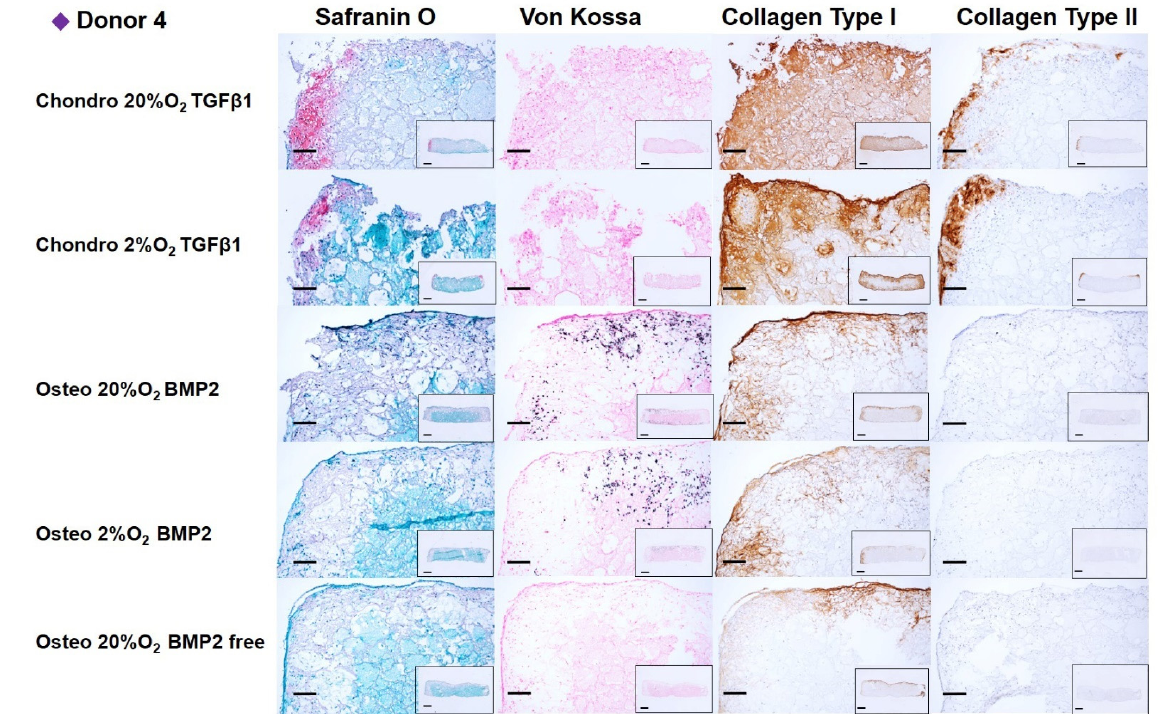
Figure 9. Chondrogenic and osteogenic hBMSC-constructs after 2 weeks of culture. Images showing a higher magnification of donor 1. Scale bar: 200 µ m. Inset: Images showing the full section of the constructs 1. Scale bar: 1 mm. Scaffolds were stained with safranin O/Fast Green, Von Kossa and immunohistochemically labelled for collagen type I and collagen type II. Chondrogenically differentiated groups showed higher Safranin O, Collagen Type I and Collagen type II deposi- tion. The osteogenically differentiated groups with BMP2 are positive for Von Kossa staining.